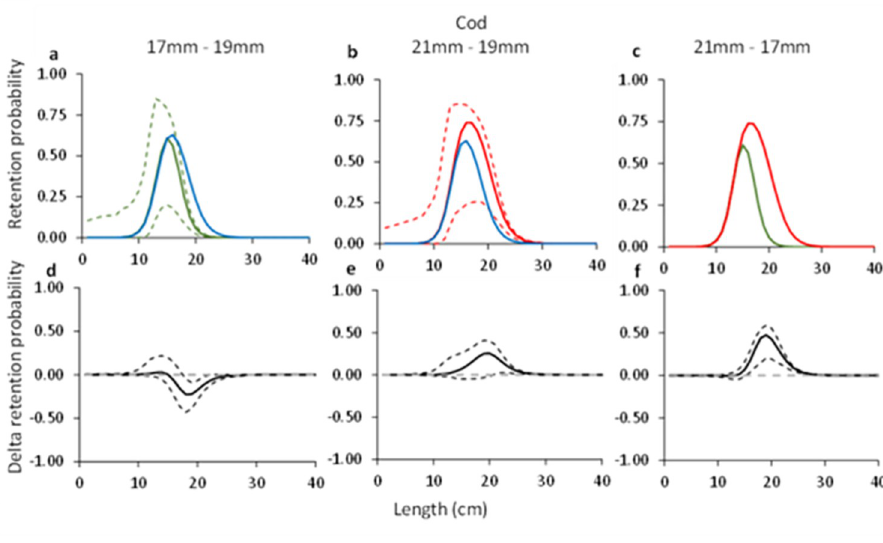
Fig 7. Combined (grid and codend) selectivity curves (a-c) and delta plots (d-f) obtained with different grid bar spacing for cod. In plots a-c, the green curve shows results for 17 mm, blue– 19 mm, and red– 21 mm grid spacing. Stippled lines are the 95%